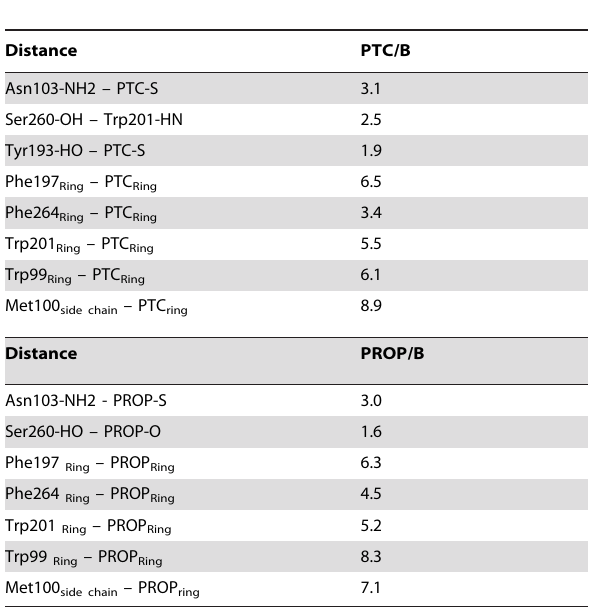
Table 1. Selected MM/CG distances (in Angstrom) in the central structure of the main clusters of the PTC/B and PROP/B adducts.